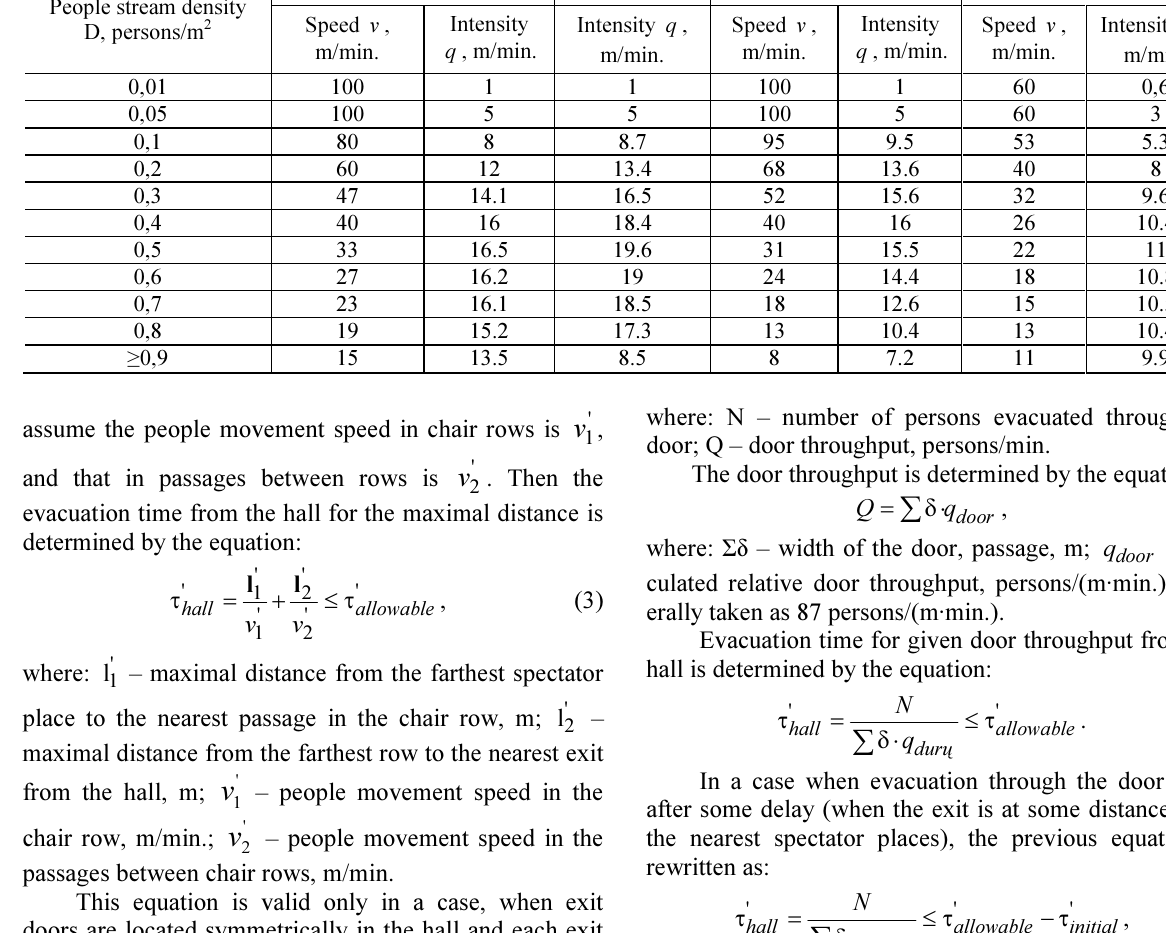
Table 1. People stream speed and intensity versus density People stream density D, persons/m